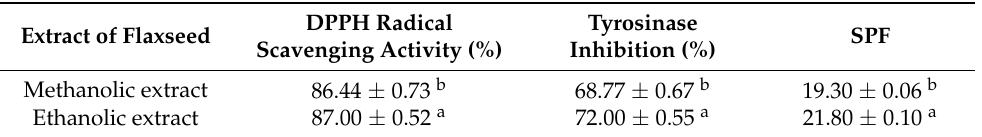
Table 4. DPPH radical scavenging activity (%), tyrosinase inhibition (%), and sun protection